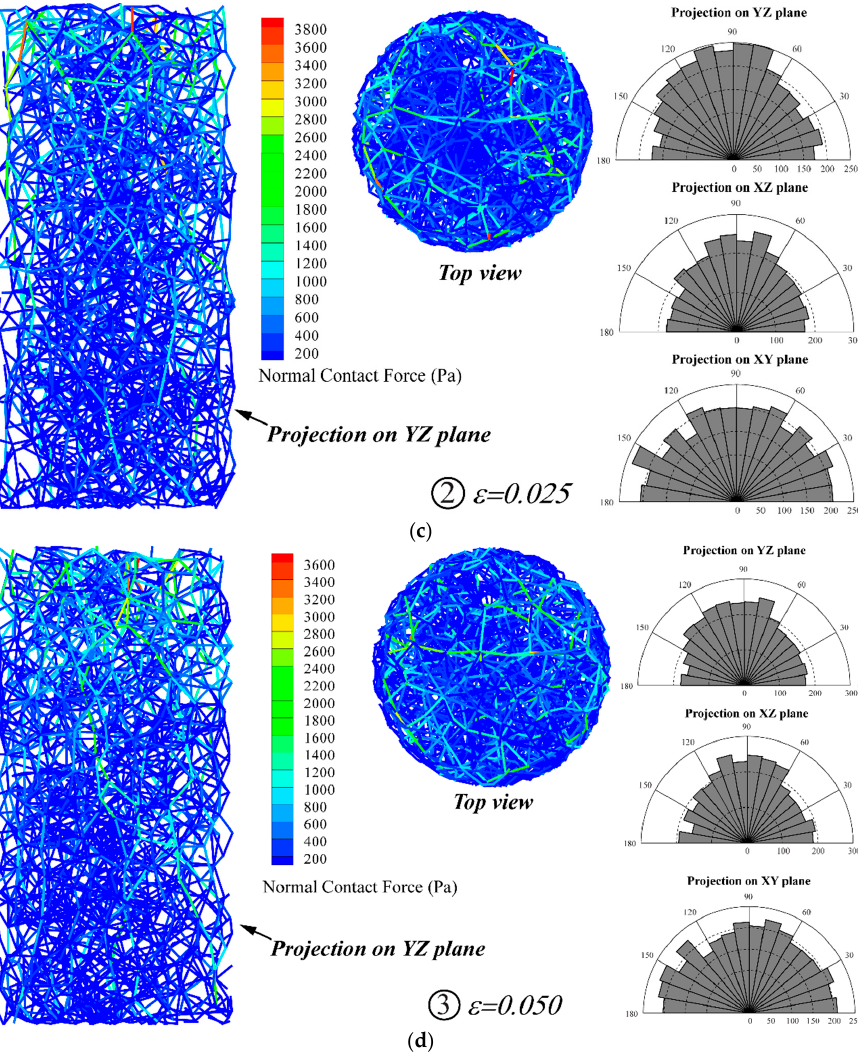
Figure 10. Micro-structure evolution of the cobble sample during triaxial compression (confining pressure: 200 kPa): ( a ) deviatoric stress–strain curve; ( b ) the sample micro-structure at ε = 0.004; ( c ) the sample micro-structure at ε = 0.025; and ( d ) the sample micro-structure at ε = 0.050.